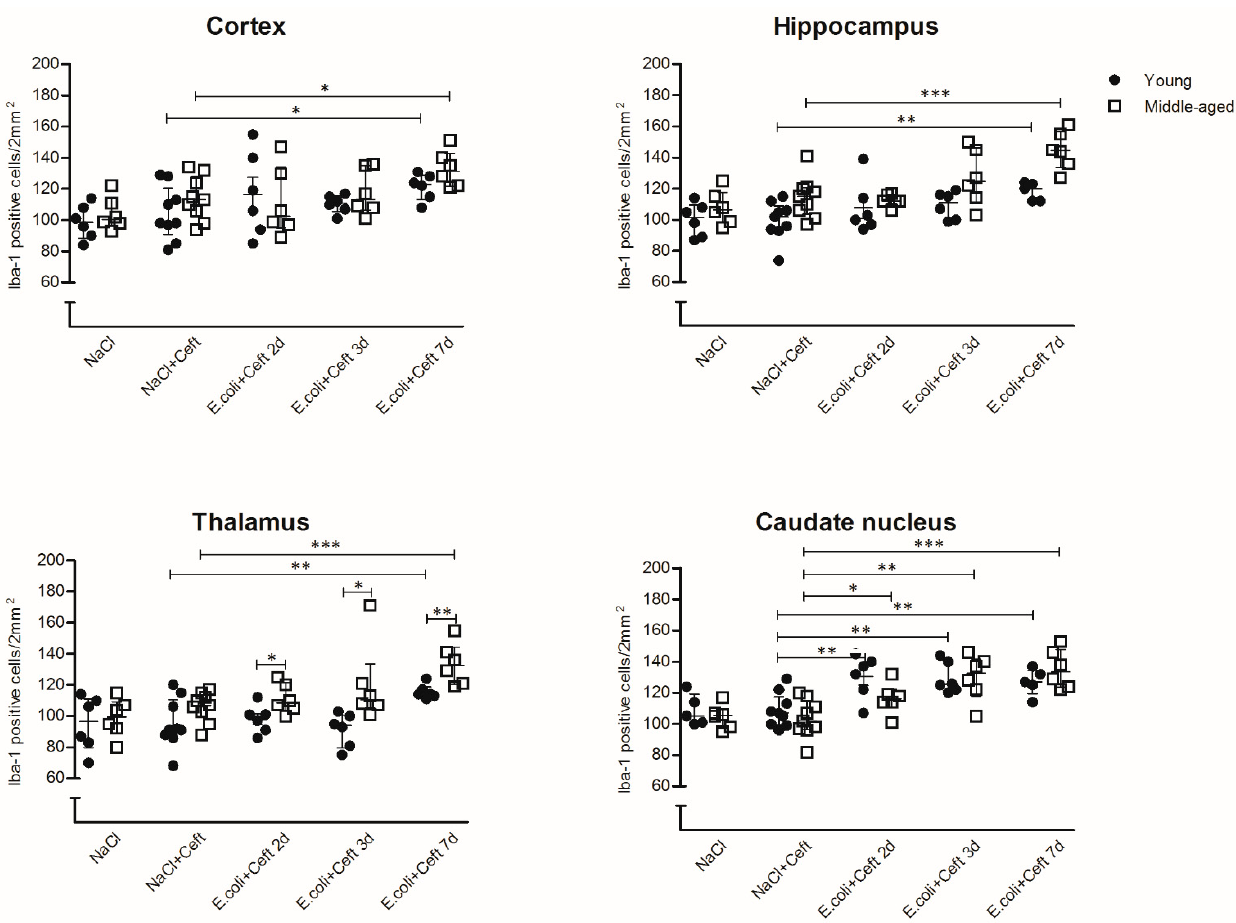
Figure 1. Histopathological counts of microglia. Number of Iba-1-positive microglial cell bodies per experimental group (NaCl: n = 6; NaCl + Ceft: n = 9; E. coli + Ceft 2, 3 and 7d: n = 6) in different brain regions (cortex, hippocampus, thalamus and caudate nucleus) per 2 mm 2 . Parametric or non-parametric two-way ANOVA (factors: age and time point) was conducted and continuous variables were tested with post-hoc Mann–Whitney U tests or Student t -tests, depending on the distribution of the data. For non-parametric ANOVAs, the ranked transformation of data was performed. Data represent median ± IQR, * p ≤ 0.05, ** p ≤ 0.01, *** p ≤